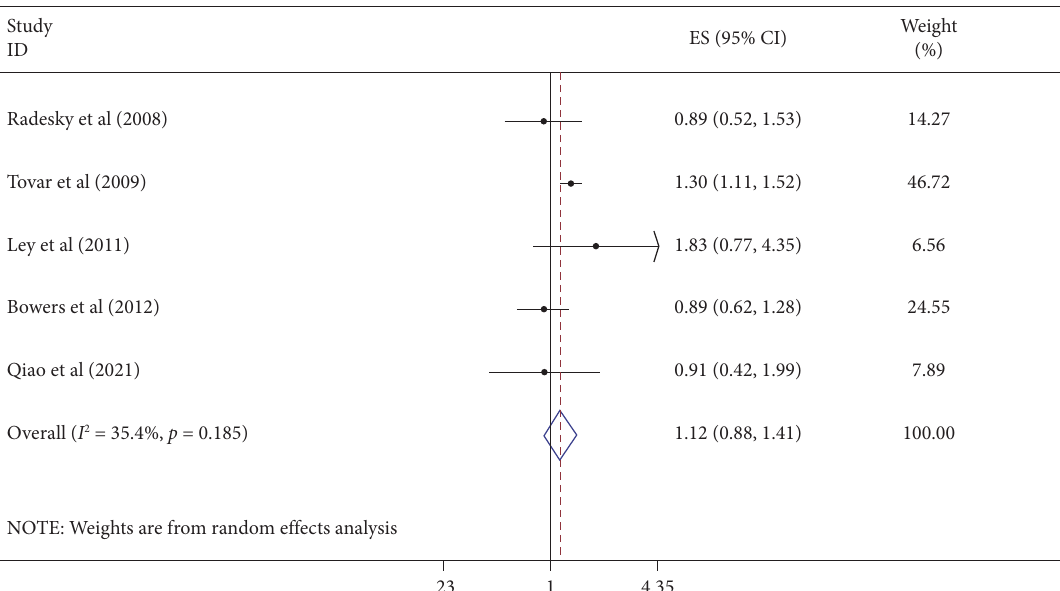
.23 Figure 4: Forest plot derived from random-efects meta-analysis of cohort studies investigating the association between high versus low intake of vegetable protein consumption and gestational diabetes mellitus. CI, confdence interval; ES, efect